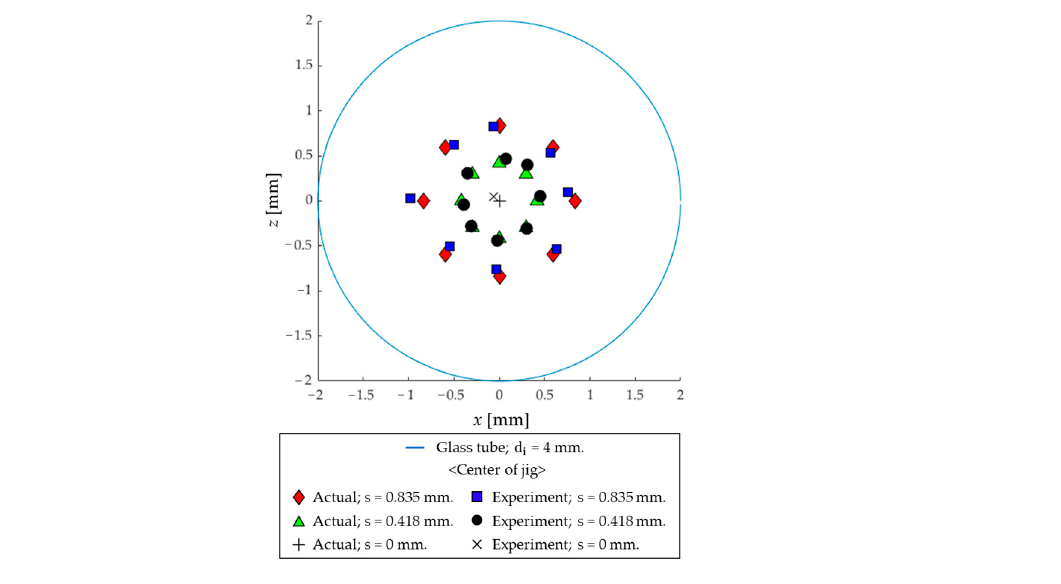
Figure 11. Actual and calculated positions on the cross-section of the glass tube (XZ-plane).